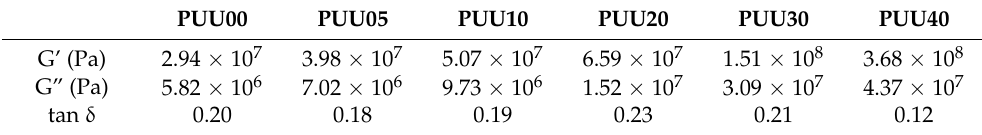
Table 2. Selected DMTA results—shear moduli and damping factors at 25 ◦ C.